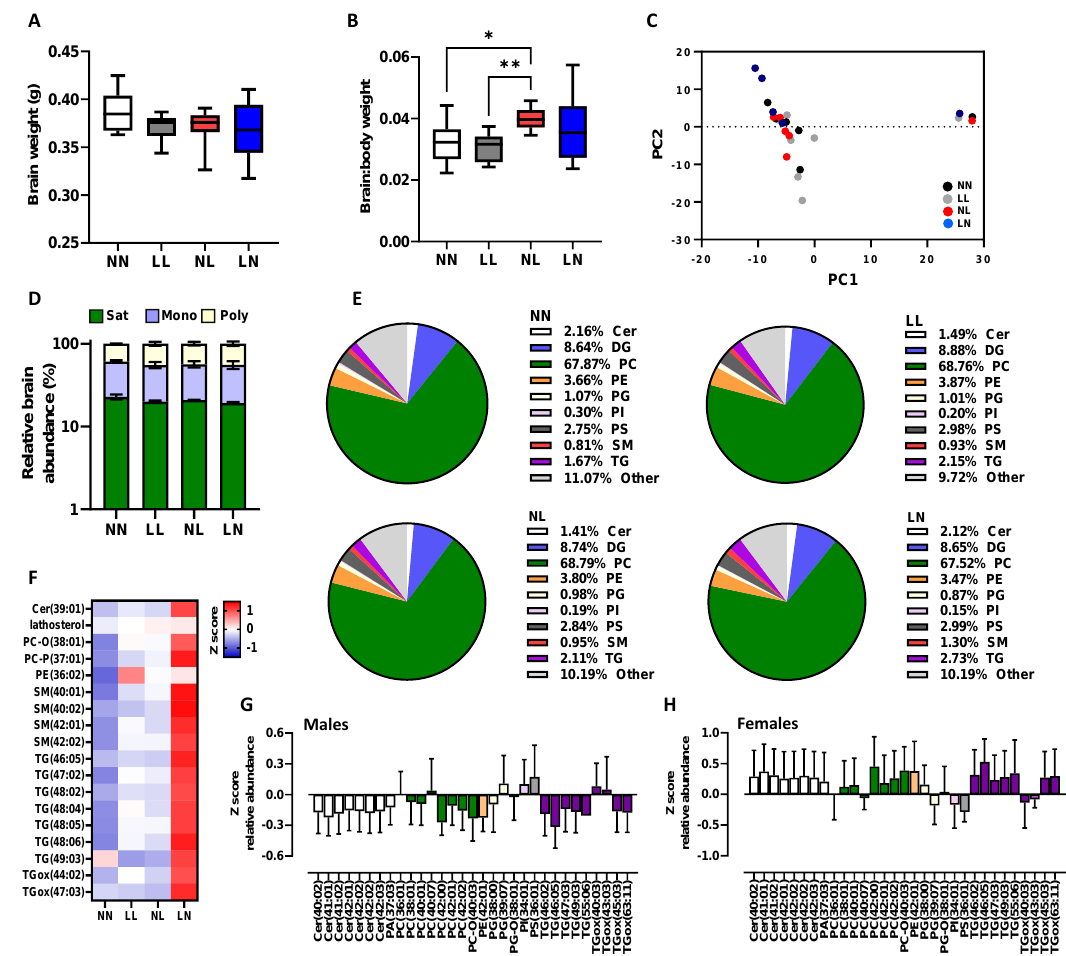
Figure 2. Impact of paternal diet on F1 neonatal offspring brain tissue lipid profiles: ( A ) the brain weight and ( B ) brain:body weight ratio of NN (NPD sperm and LPD seminal plasma), LL (LPD sperm and LPD seminal plasma), NL (NPD sperm and LPD seminal plasma) and LN (LPD sperm and NPD seminal plasma) offspring at 3 weeks of age. ( C ) Principal component analysis (PCA) of differential lipids in NN, LL, NL and LN offspring brains. ( D ) Relative levels of saturated, mono-unsaturated and poly-unsaturated lipids in NN, LL, NL and LN offspring brains. ( E ) Relative levels of ceramides (Cer) diglycerides (DG; water-loss product from fragmentation in source), phosphatidylcholines (PC), phosphatidylethanolamines (PE), phosphatidylglycerols (PG), phosphatidylinositols (PI), phosphatidylserine (PS), sphingomyelins (SM), triglycerides (TG) and other lipids in NN, LL, NL and LN offspring brains. ( F ) Z scores of differential lipids between NN, LL, NL and LN offspring brains. Differential lipid abundance in ( G ) male and ( H ) female offspring. N = 5–6 offspring (2–3 males and females) per treatment group, sampled from all litters generated. Data are expressed as mean ± SEM ( A , B ). * p < 0.05, ** p < 0.01. Statistical differences were determined using a random effects regression analysis ( A , B ) or one-way ANOVA with Bonferroni post hoc correction ( D – H